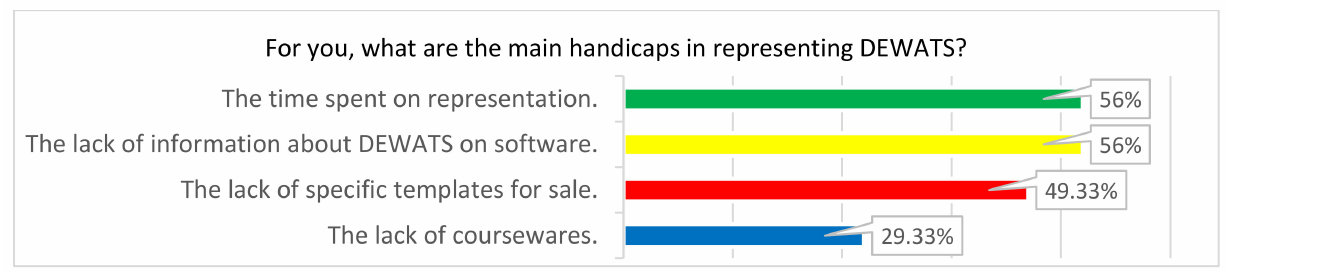
Figure 7. Answers to the fifth question. Source: authors (2020).